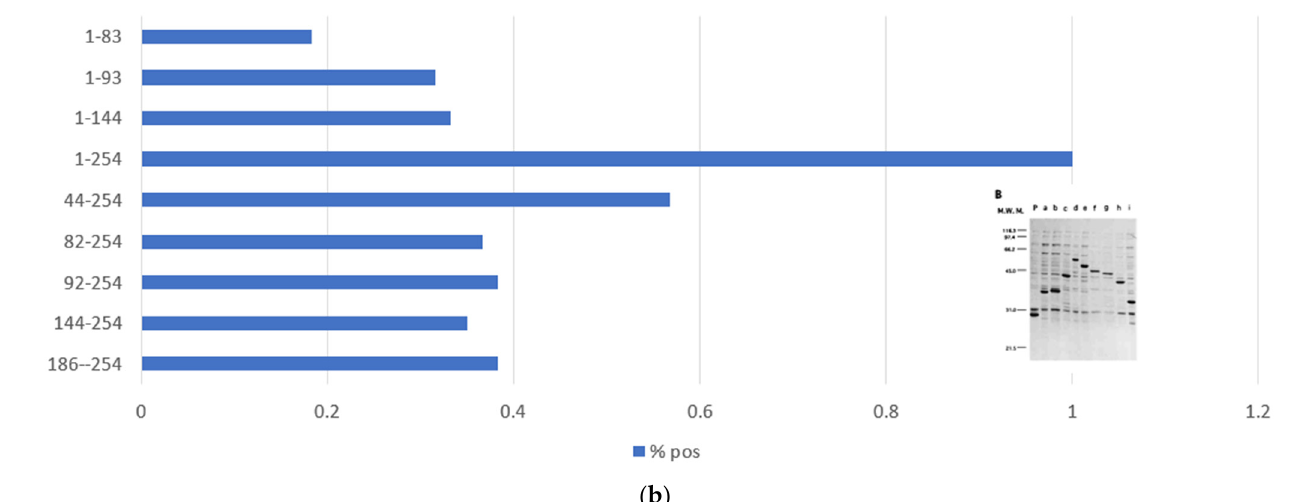
Figure 2. Epitope distribution on the Ki/SL antigen. ( a ) shows a visual representation of the recombinant truncated fragments (and full-length) of the Ki/SL antigen and the corresponding reactivity study by Matsudaira et al. [27] (Panel ( b )) Shows the fraction of patients reacting with the recombinant fragments.